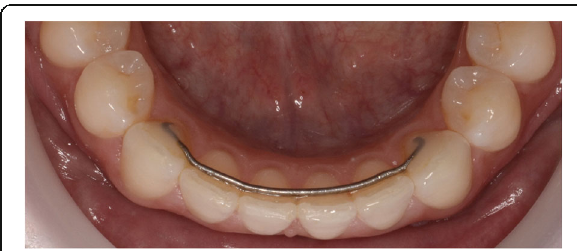
Fig. 3 .027 ″ round TMA wire (ORMCO) bonded to lower canines only at T 3